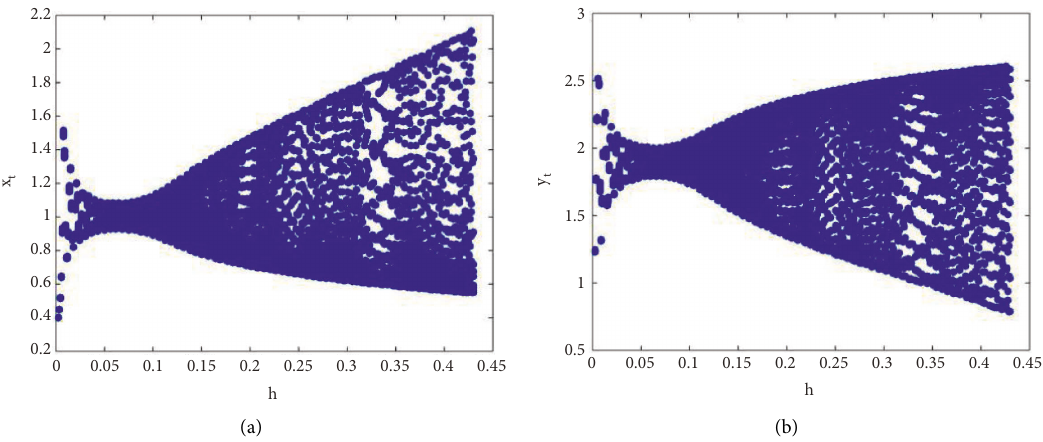
Figure 3: Hopf bifurcation diagrams of the Brusselator system (10) with ( 1 . 5 , 1 . 5 ) and h ∈ [ 0 . 0003 , 0 . 55 ] .